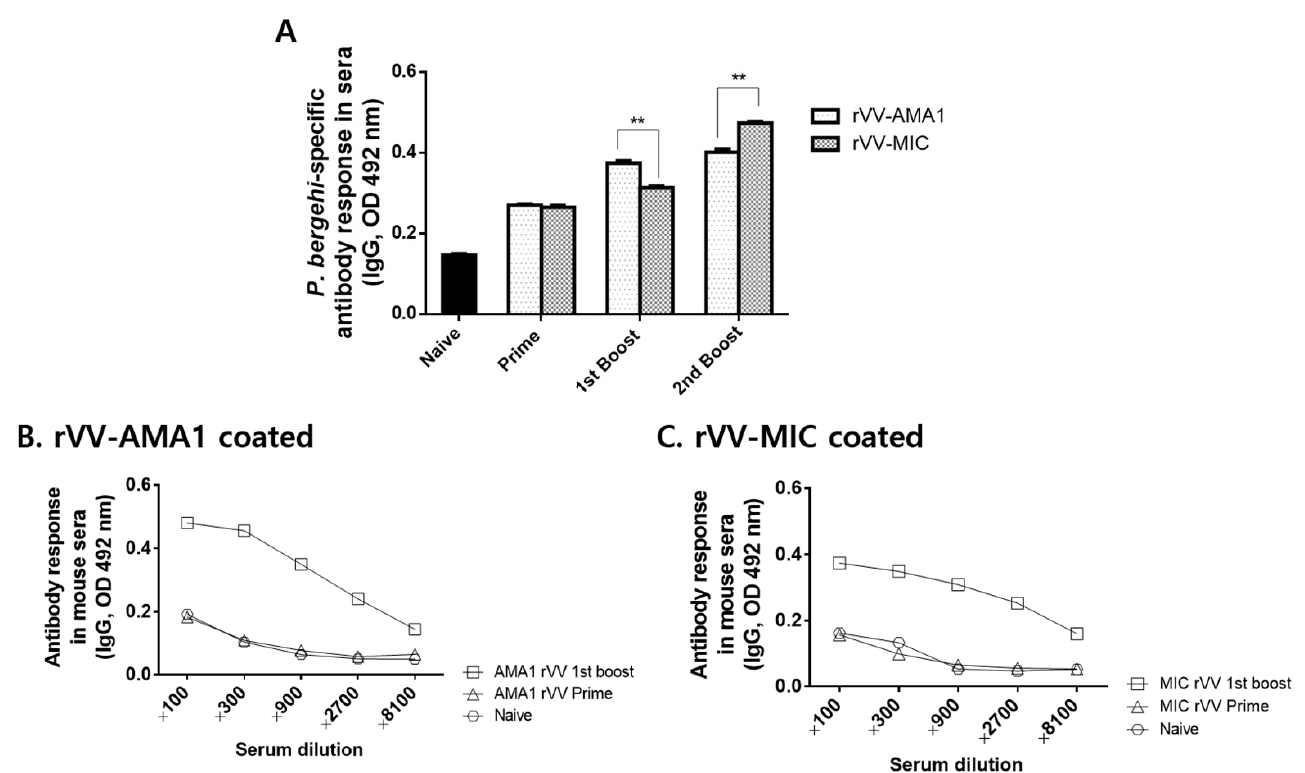
Figure 3 . IgG antibody response in sera. On week 4 after prime, 1st boost, and 2nd boost immunization, the sera of mice were collected to investigate the levels of IgG antibody response. The 96-well immunoplates coated with P. berghei antigen ( A ), rVV-AMA1 ( B ), or rVV-MIC ( C ) were used to verify IgG antibody response by ELISA. Data are expressed as mean ± SD (** p < 0.01).